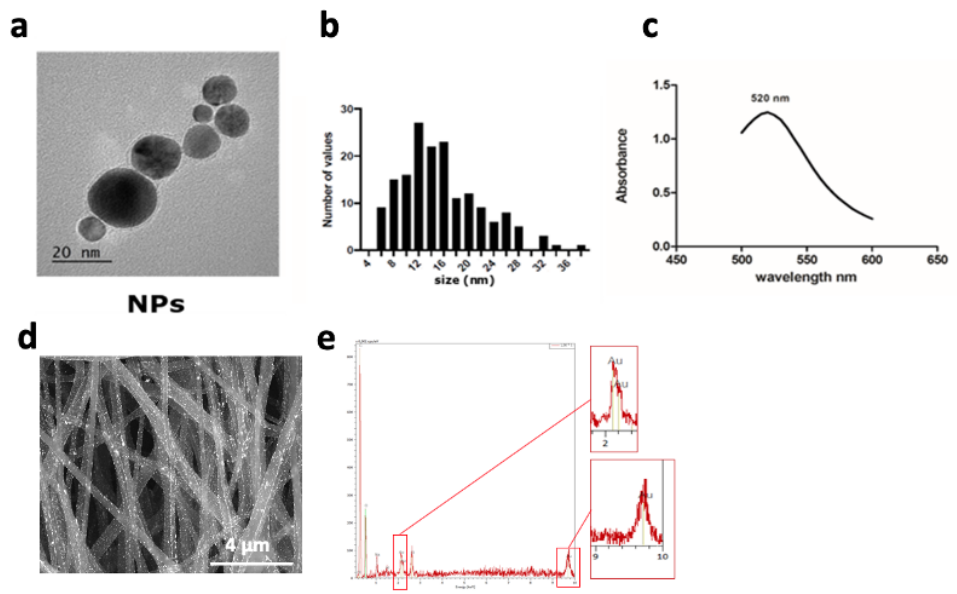
Figure 2. Characterization of the gold nanoparticles coated on the PCL scaffold. ( a ) TEM images of Au nanoparticles formed on the fibers, (presenting a s ize of 15 ± 6 nm ). ( b ) Particle size distribution from TEM image analysis ( n = 30 particles) and ( c ) absorption spectrum of gold nanoparticle solutions using a spectrometer, with a peak of absorbance at a wavelength of 520 nm ( n = 3). ( d ) SEM images of electrospun fibers coated with Au NPs, ( e ) EDS spectrum showing the 3 peaks for Au elements at 2.10, 2.20, and 9.7